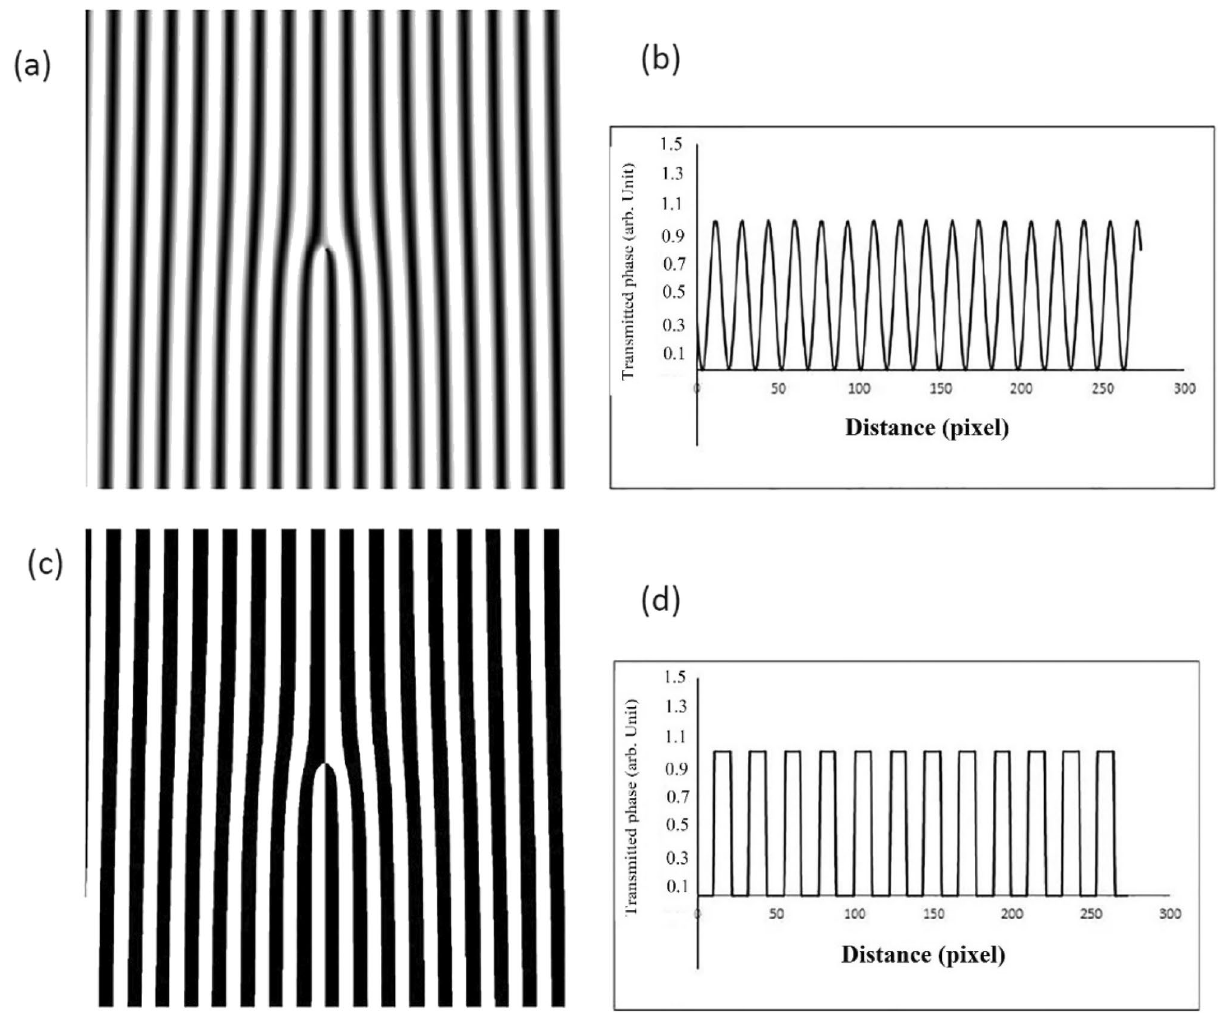
Figure 1. ( a ) Sinusoidal phase fork grating, ( b ) transmitted phase profile of sinusoidal phase fork grating, ( c ) binary phase fork grating, ( d ) transmitted phase profile of binary fork